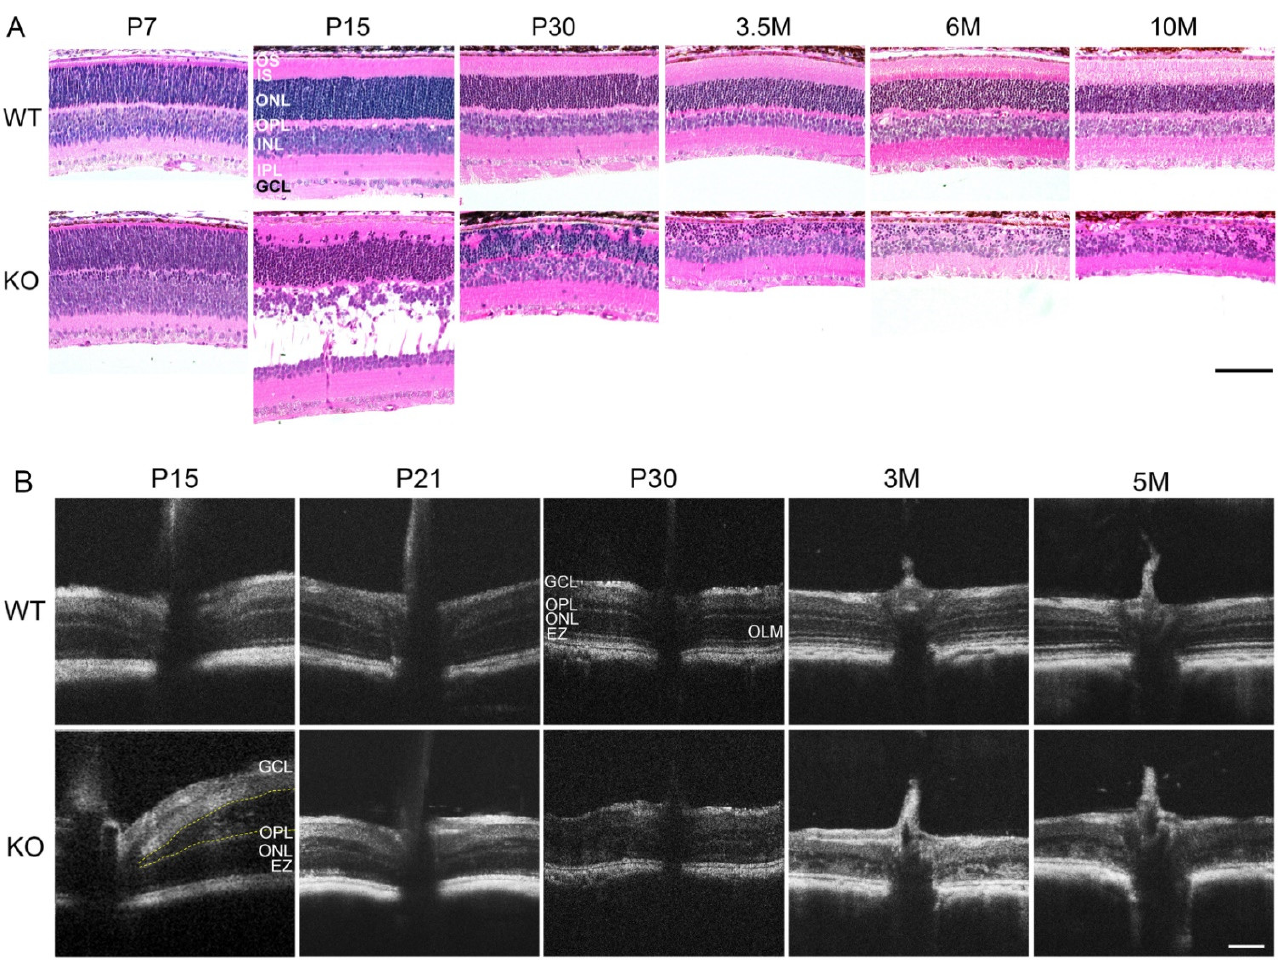
Figure 2. Retinal structural changes of Rs1 -/Y rat. ( A ) Histology of WT and Rs1 -/Y (KO) retinas. Retinas at post-natal day 7 (P7) showed essentially no differences in lamination at this magnification. At P15, large schisis cavities formed in the inner nuclear layer (INL) of the KO retina, and a few photoreceptor nuclei were dislocated into the photoreceptor inner segment (IS) zone. A greater number of the outer nuclear layer (ONL) cells (arrowheads) were dislocated into the IS/outer segment (OS) zones. At P30, only approx. 40% of the ONL cells remained, and the outer plexiform layer (OPL) was disrupted. From 3.5 months on, the thickness of the ONL was reduced, and only approx. 10% of the ONL remained at 10 months. The ONL lamination appeared more orderly as the displaced cells had mostly been eliminated. Scale bar = 100 µ m. ( B ) Optical coherence tomography (OCT) imaging of WT and KO retinas. An extensive retinal cavity was observed in the INL starting at the optic nerve of KO rats at P15, but cavities were resolved by P21. KO retinas showed progressive degeneration in the outer retina with aging. ONL thickness of KO retina was reduced by approx. 60% at P30 compared to WT, and the ONL, OPL, outer limiting membrane (OLM) and ellipsoid zone (EZ) were disrupted. More severe degeneration was seen at 3 (3 M) and 5 months (5 M), and the retinal lamination was hardly evident compared to the WT. Scale bar = 200 µ